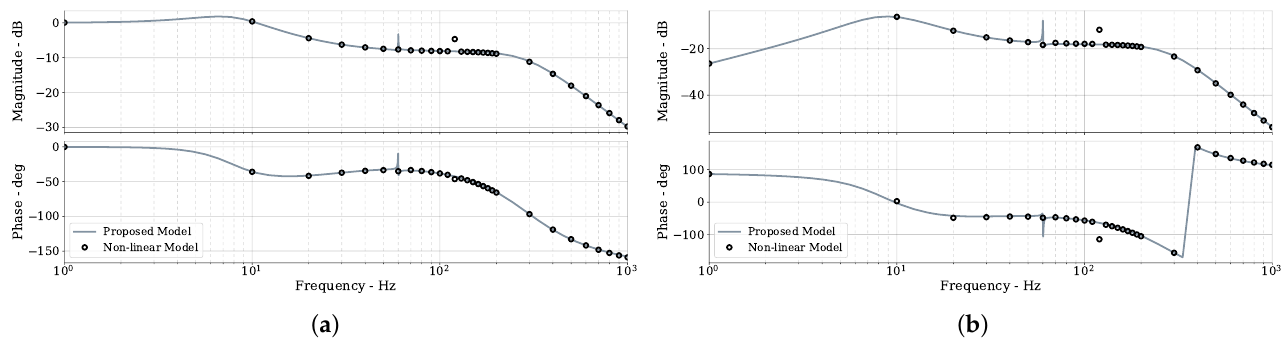
Figure 6. Frequency responses for the proposed (linearized) and non-linear models for G th . ( a ) Self- related term; ( b ) Cross-coupling